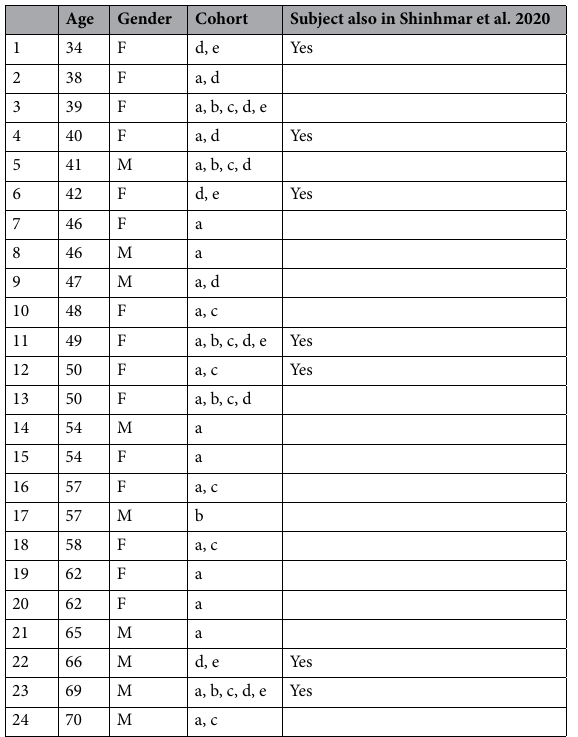
Table 1. Subject demographics: a breakdown of the subjects used in different parts of the study. F Female, M Male. a = AM light exposure. b = PM light exposure. c = AM light exposure tested a week later. d = AM control, no light exposure. e = variation across the day.